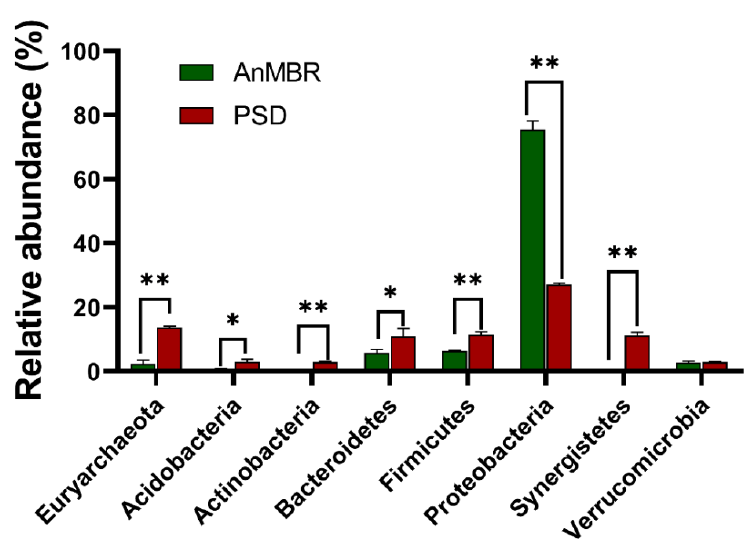
Figure 2. Taxonomic composition of the microbial communities showing the differences between the PSD and AnMBR samples. The data reveal the phylum- and genus-level classification of the 16S rRNA gene sequences. 16S rRNA gene sequences longer than 250 bp were classified using the RDP naïve Bayesian rRNA Classifier at an 80% confidence threshold. Only the relative abundances of the identified phyla higher than 1% are listed. The average ± SD values of the samples in each group are expressed in each column. The significance of the cuto ff for the corrected p -value using the Benjamini–Hochberg FDR procedure was set at 0.05. The significant di ff erences within the sampling group are labeled **, where p <